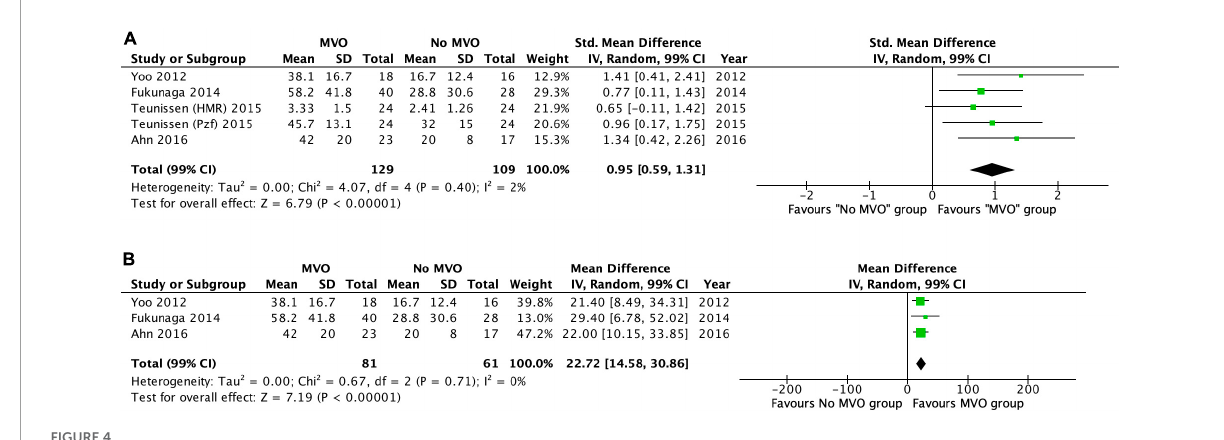
FIGURE4 (A) Forest plot of IMR, HMR, and Pzf in patients with and without MVO by CMR. Forest plot of the six studies included and shows the weighted standardized mean difference of vascular resistance indices in those with and without microvascular obstruction (MVO) by cardiac magnetic resonance imaging (CMR). (B) Forest plot of IMR in patients with and without MVO by CMR. Forest plot of the four index microvascular resistance (IMR) studies included and shows the weighted mean difference of IMR in those with and without microvascular obstruction (MVO) by cardiac magnetic resonance imaging